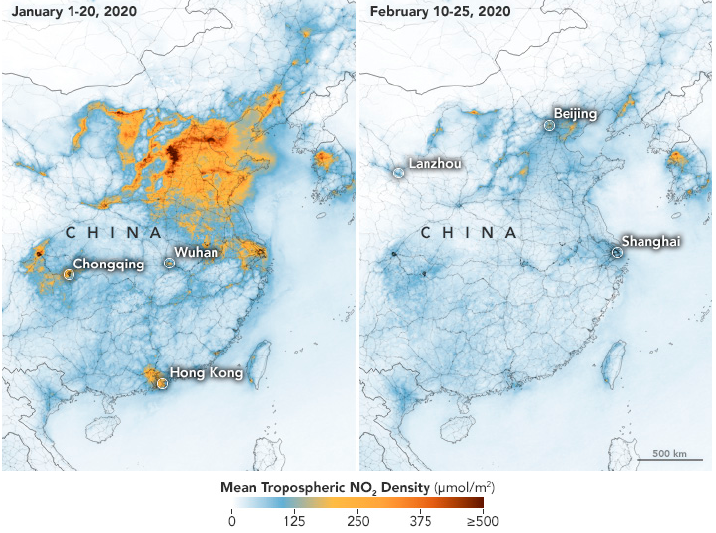
Figure 5. Mean tropospheric NO 2 values retrieved by NASA Aura and ESA S5TROPOMI pollution monitoring satellites over north-eastern China in January and February 2020. Source: https://earthobservatory.nasa.gov/images/146362/airborne-nitrogen-dioxide-plummets-over-china.